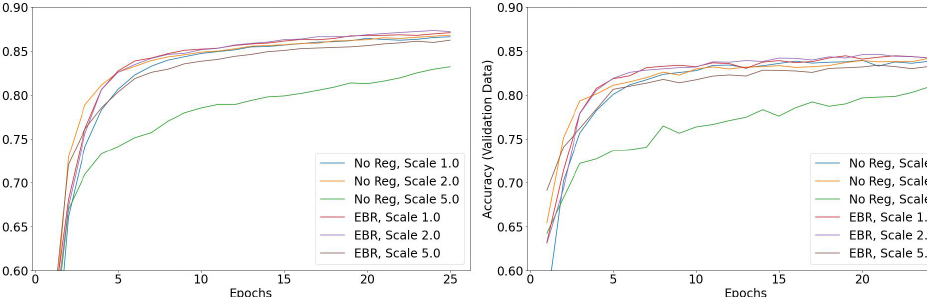
Figure 5. Comparison of cross-entropy loss for different variance scales of the initializer for layers with and without regularization ( left panel shows results for training data, right panel for validation data).